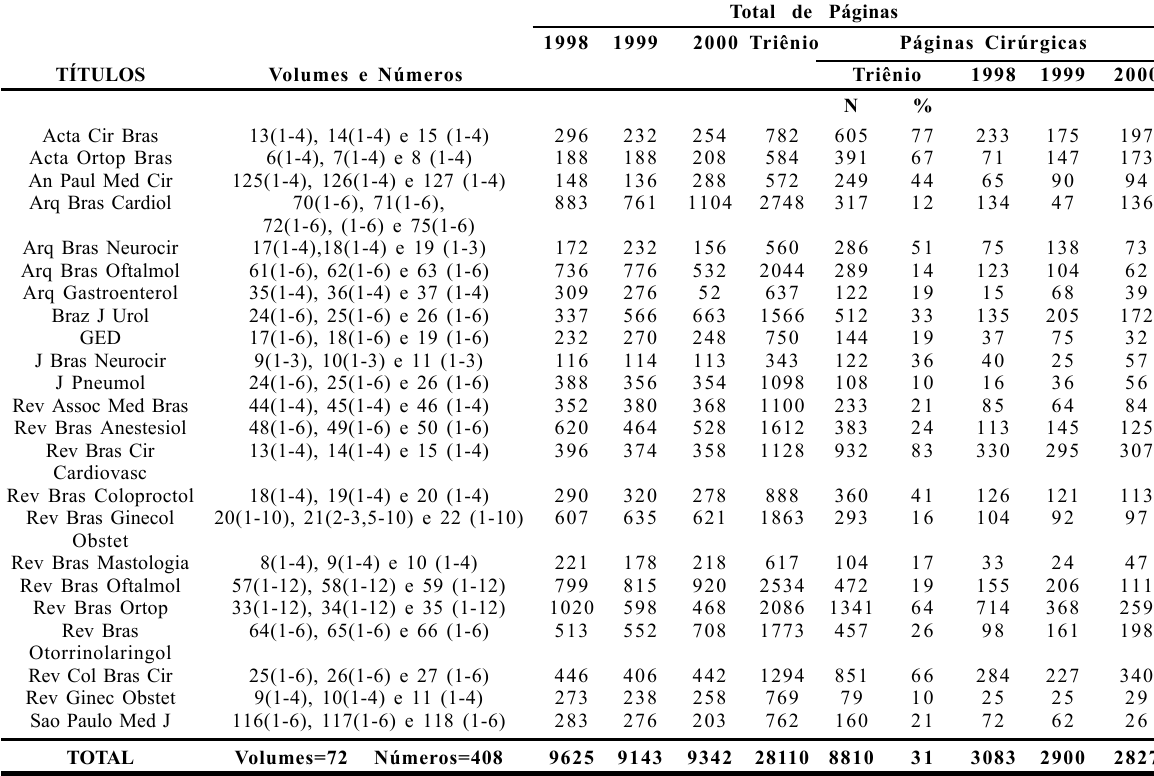
Distribui(cid:231)ªo das